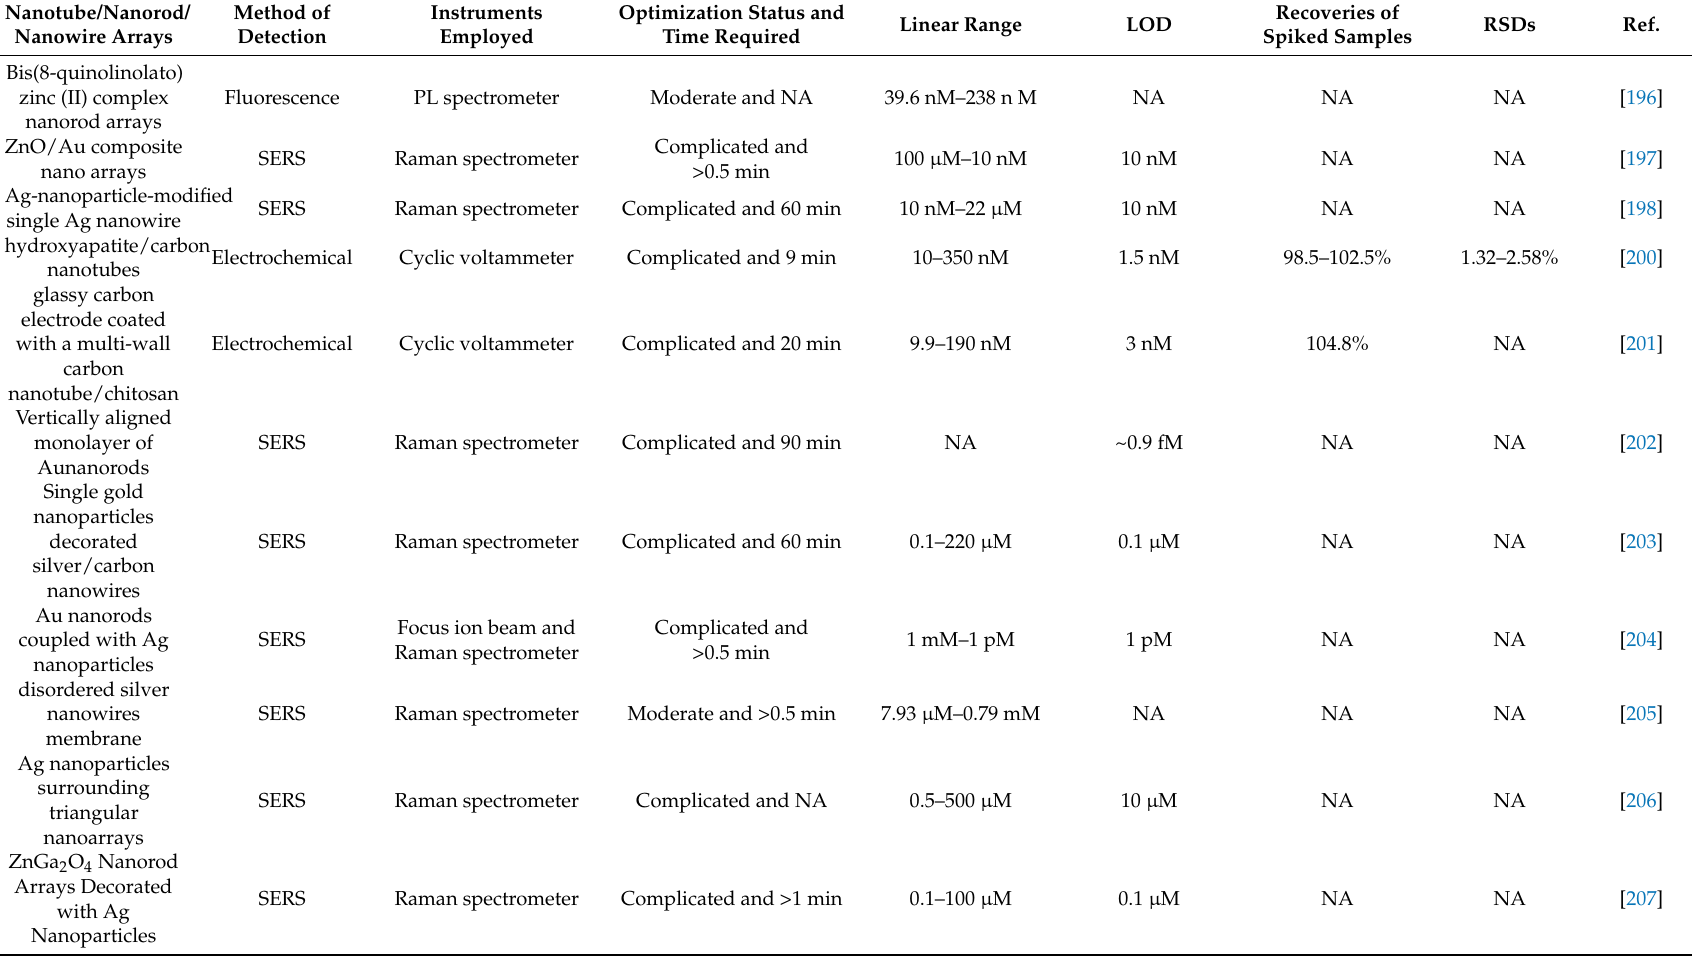
Table 3. Summary of methods, instruments, optimization status, time, linear ranges, detection limits (LODs), recoveries and relative standard deviations (RSDs) of Nanorods and Nanotubes-based probes in melamine